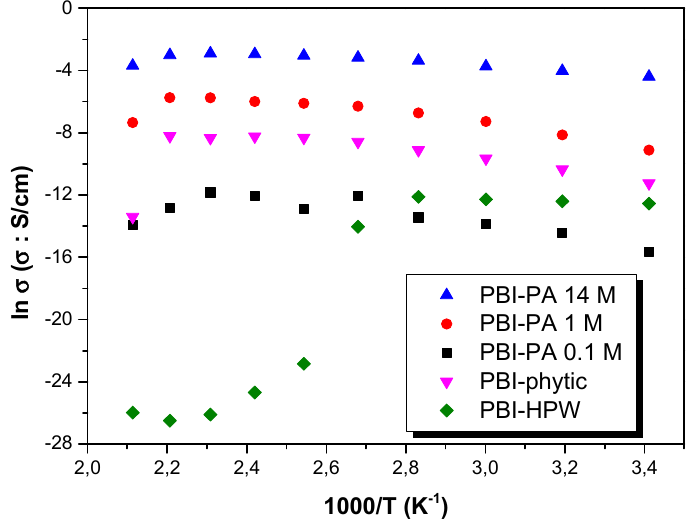
Figure 8. Temperature dependence of proton conductivity ( σ ) in all the range of temperatures for PBI–PA 0.1 M ( (cid:4) ), PBI–PA 1 M ( • ), PBI–PA 14 M ( (cid:78) ), PBI–phytic acid (0.075 M) ( (cid:72) ), and PBI–HPW (0.1 M) ( (cid:7) ) membranes.